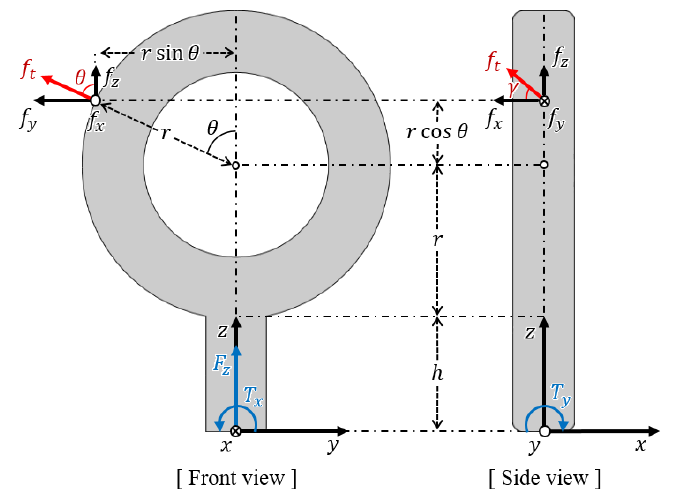
Figure 6. Force and torque configuration with the decomposed forces applied to the